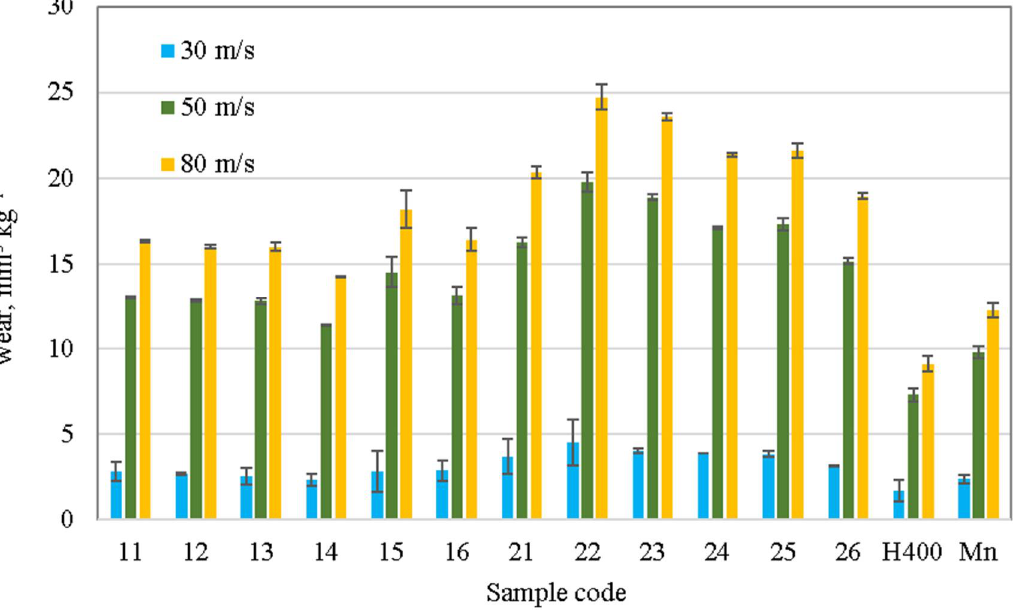
Figure 7. Effect of erodent impact velocity on wear rate of materials tested under impact angle of 90°.